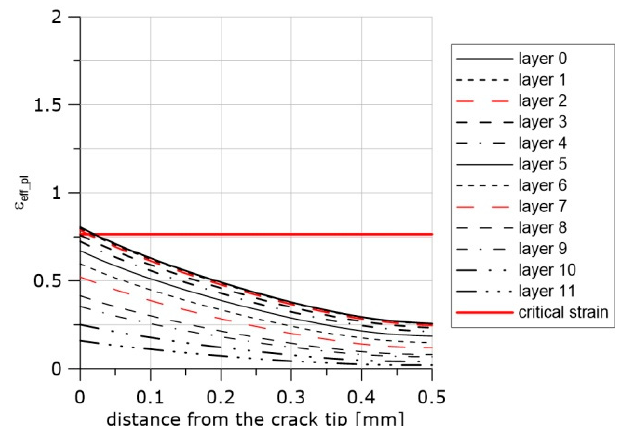
Figure 16. Distributions of the effective plastic strain in front of the crack along the crack front at the final moment of loading after calibration using specimen PR and the material softening option, material HW, temperature +20 °C.